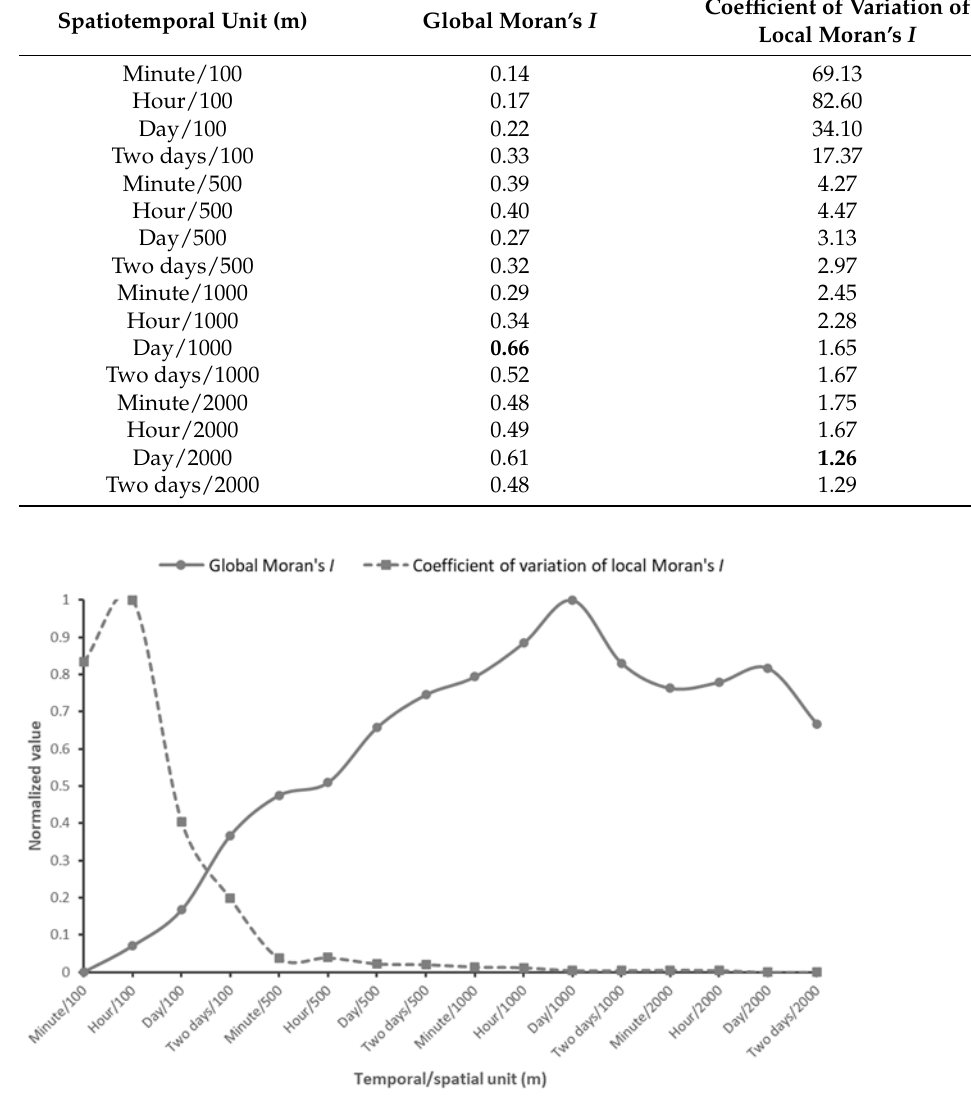
Figure 5. Normalized global spatial correlation and local spatial stability.